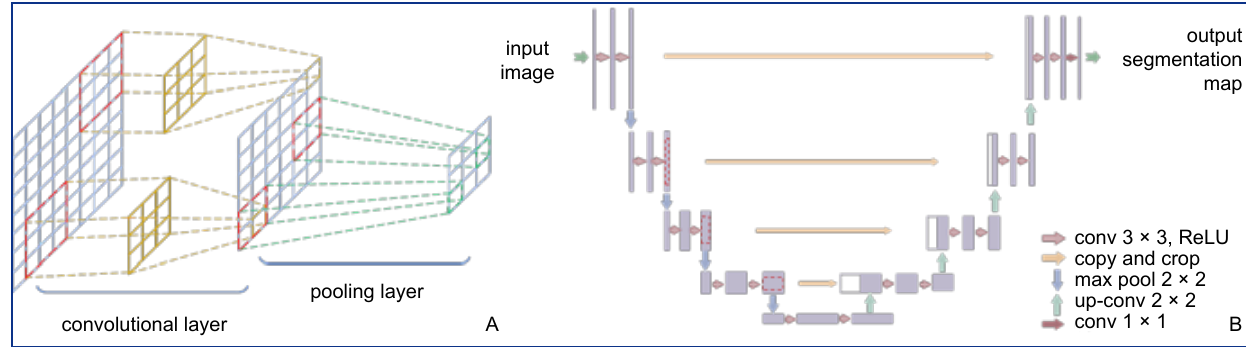
Figure 1 The basic structure of convolutional neural network. (A) The general structure of CNN; (B) The U-Net architecture based on CNN.